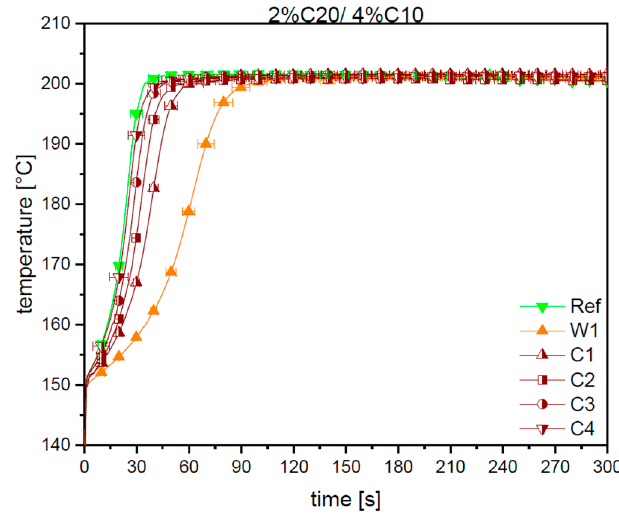
Figure 9. Compensation series of formulation 3 (2% C20, 4% C10). Polymerized at T pol = 150 °C and T mold = 150 °C.